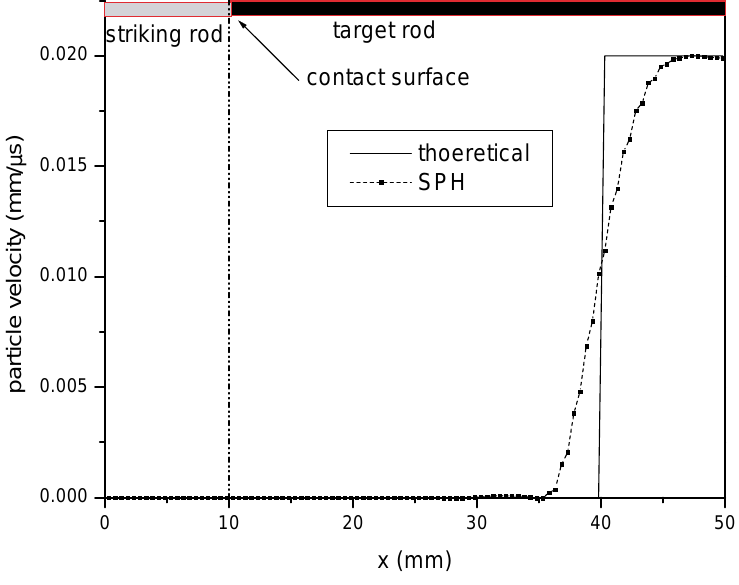
Fig. 2. Particle velocity distribution at time (Case